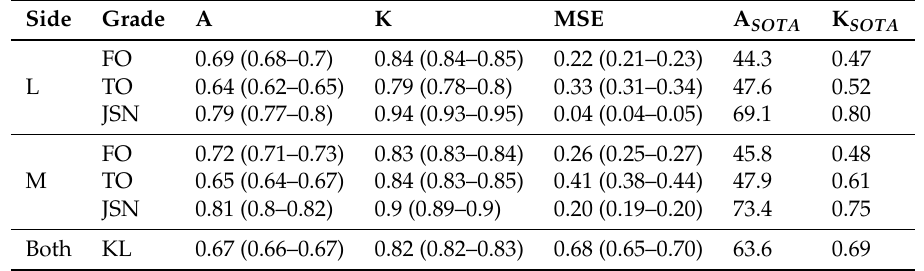
Table 3. Test set performance of our ensemble method with SE-Resnet50 and SE-ResNext50-32x4d backbones. MSE, A and K indicate the mean squared error, balanced accuracy and Cohen’s kappa, respectively. As a comparison, the three rightmost columns show the state-of-the-art (SOTA) performance reported by Antony et al. in a similar work. L and M indicate lateral and medial compartments, respectively. FO and TO indicate femoral and tibial osteophytes and JSN indicates joint space narrowing, respectively. KL indicates the Kellgren–Lawrence